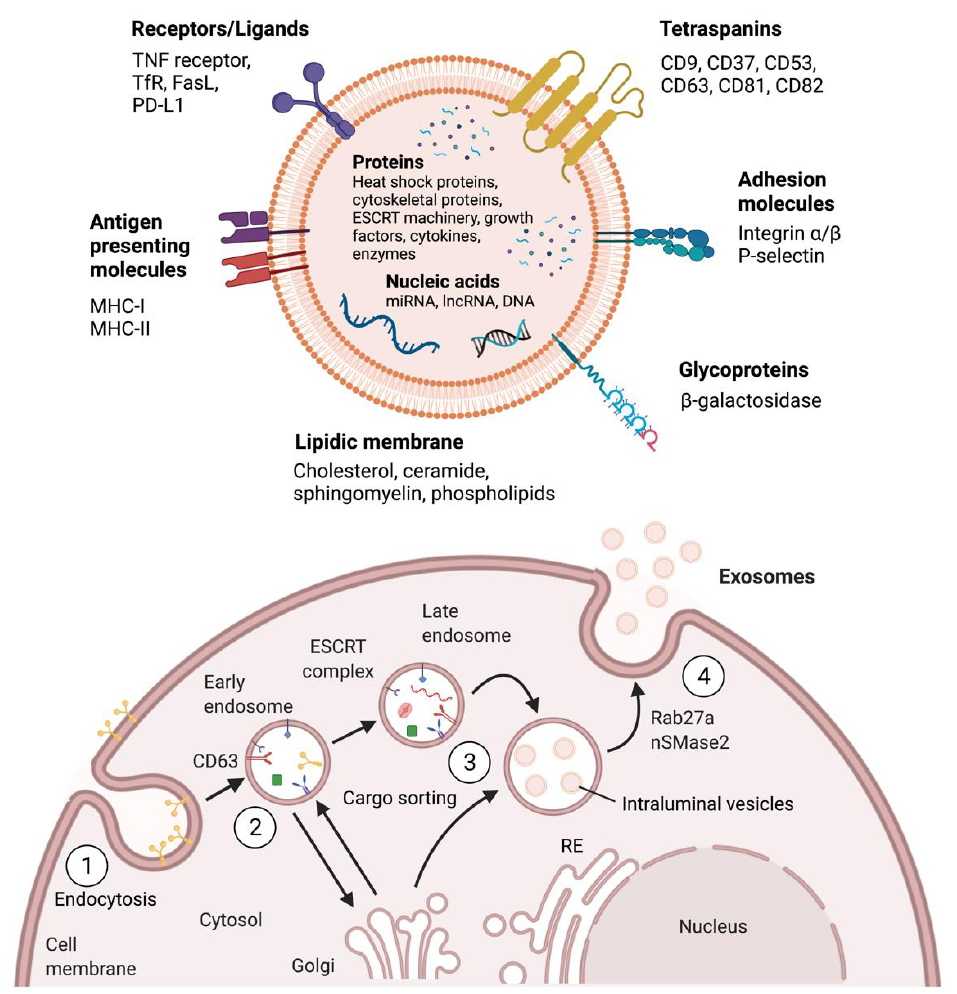
Figure 1. A simplified representation of exosome biogenesis and composition. (1) Exosome biogenesis begins by inward budding of the cell membrane. (2) Tetraspanins such as CD63 are proposed to mediate early endosome formation and transport. (3) The ESCRT complex and associated proteins sort proteins, DNA and RNA species into exosomes and are proposed to mediate late endosome formation. (4) Late endosomes are multivesicular bodies that fuse to the cell membrane and release exosomes to the extracellular space, a process that has been associated with Rab27a and nSMAse2 activity. Exosomes are formed by a lipidic bilayer with receptors, ligands, and transmembrane proteins, while soluble proteins, DNA and RNA species are enclosed in the lumen.